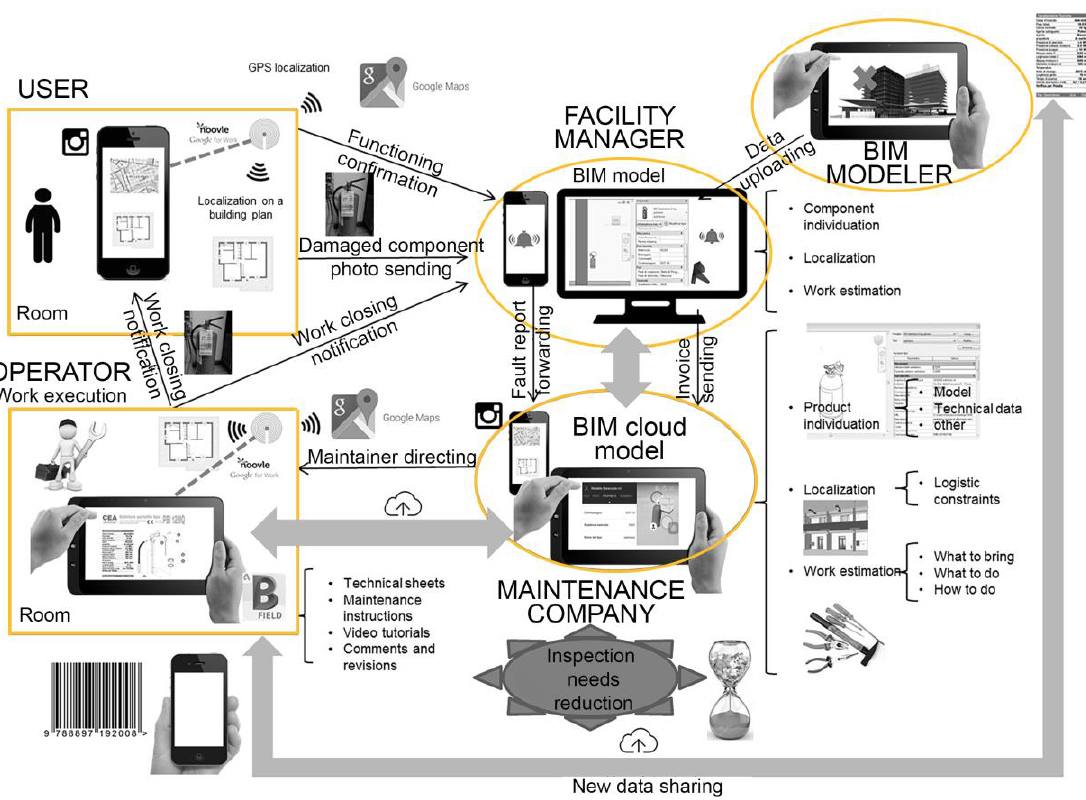
Figure 10. Flowchart of the process implemented in the case study.